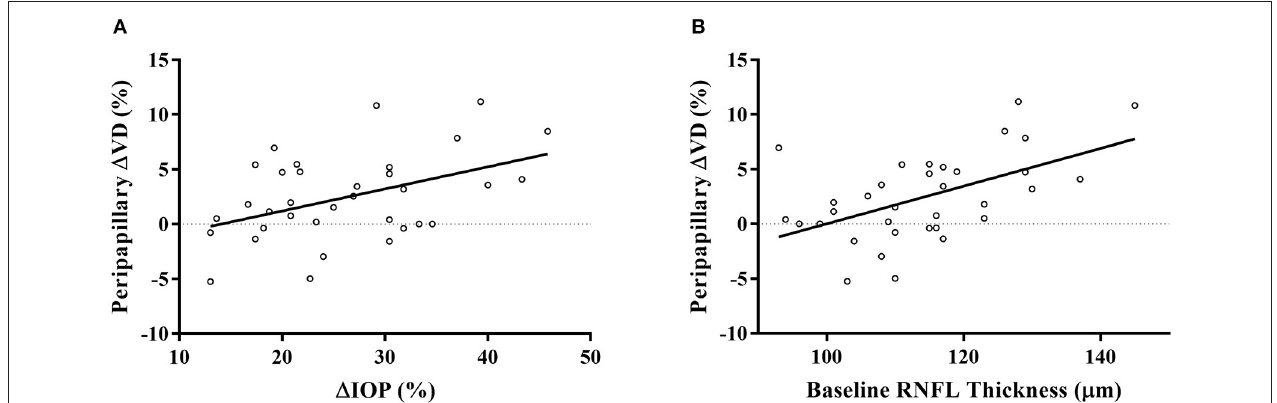
FIGURE 2 | Scatterplots displayed the significant association of IOP reduction percentage (A) and baseline RNFL thickness (B) with the percentage of peripapillary VD increase after treatment. 1 VD represented the percentage of VD change after a 4-week latanoprost application. 1 IOP represented the percentage of IOP reduction of each